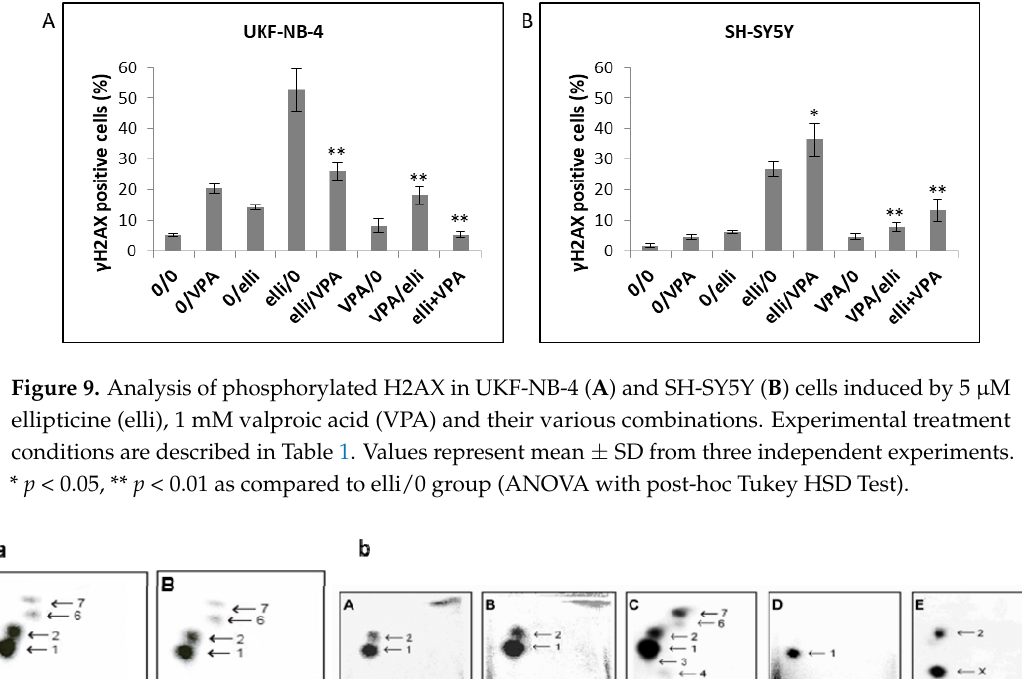
Figure 9. Analysis of phosphorylated H2AX in UKF-NB-4 ( A ) and SH-SY5Y ( B ) cells induced by 5 µM ellipticine (elli), 1 mM valproic acid (VPA) and their various combinations. Experimental treatment conditions are described in Table I. Values represent mean ± SD from three independent experiments. * p < 0 .05, ** p < 0 .01 as compared to elli/0 group (ANOVA with post-hoc Tukey HSD Test).